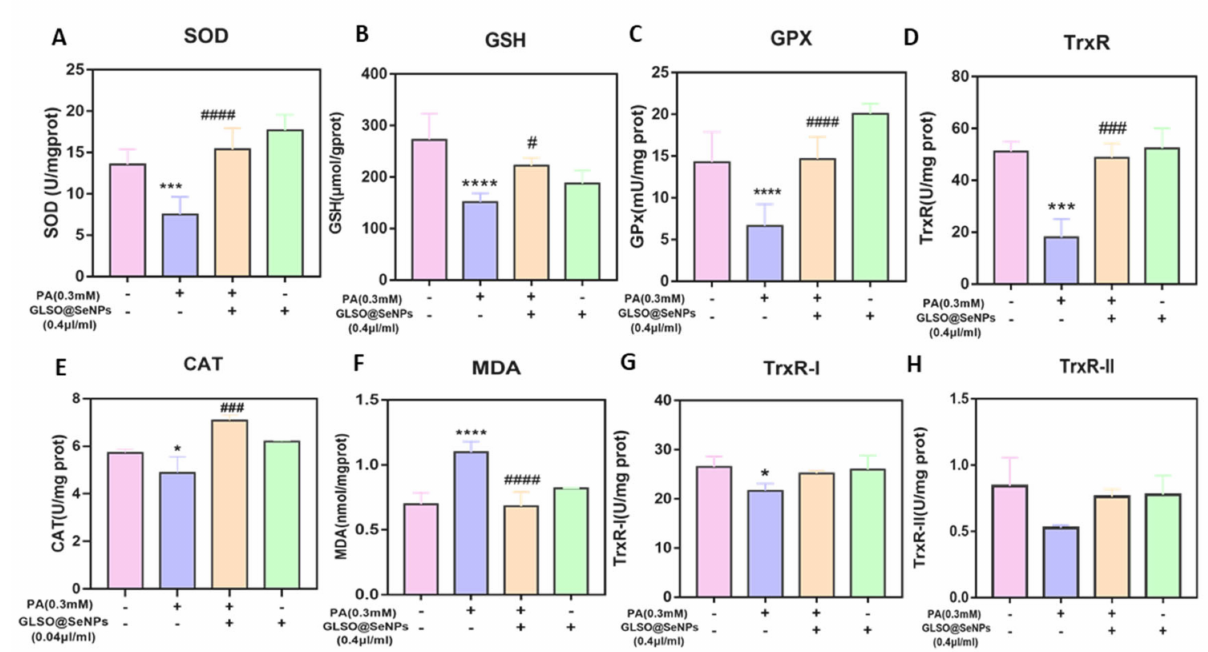
Figure 6. Determination of oxidative stress-related enzymes in cells. SOD content ( A ), GSH content ( B ), GPX activity ( C ), TrxR activity ( D ), CAT activity ( E ), MDA content ( F ), and TrxR-I activity in mitochondria ( G ), as well as TrxR-II activity in intracellular cytoplasmic proteins ( H ) in INS-1E cells of each drug treatment group. (* (#) p < 0.05 means the lowest significance, *** (###) p < 0.001 means high significance, **** (####) p < 0.0001 means the highest